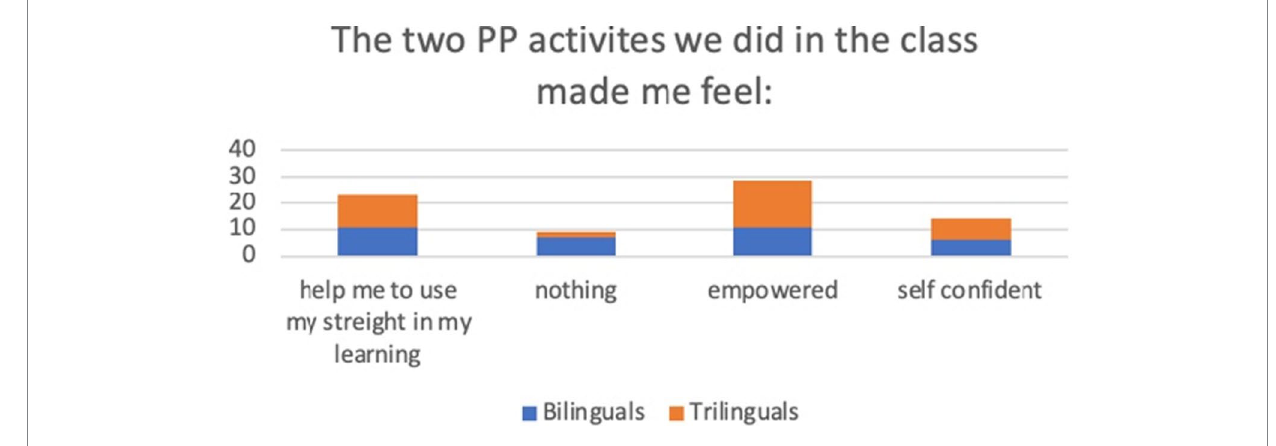
FIGURE 4 Histogram the answers to question 3.